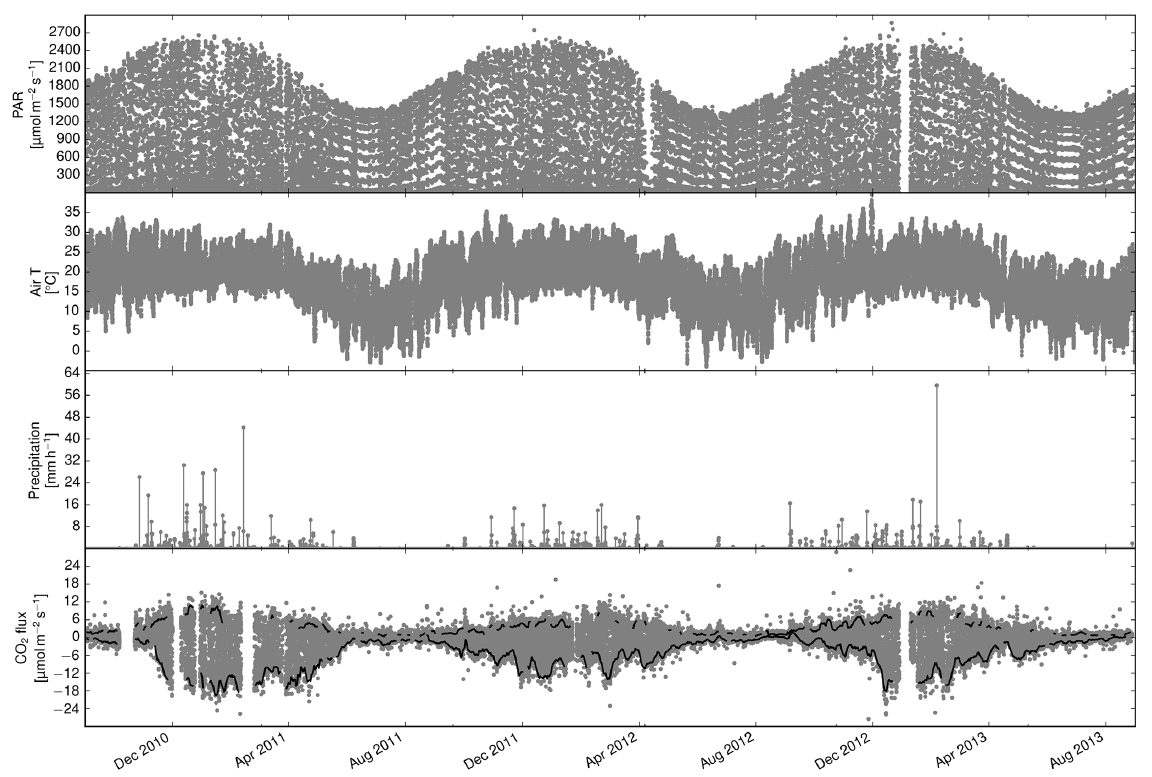
Figure 2. Time series of incoming PAR, air temperature, precipitation and CO 2 flux for the measurement period from September 2010 to August 2013. The solid lines within the CO 2 flux data show the 5-day centered mean of minimum daytime and maximum night-time CO 2 flux. Incoming PAR, air temperature and CO 2 flux data are 30min